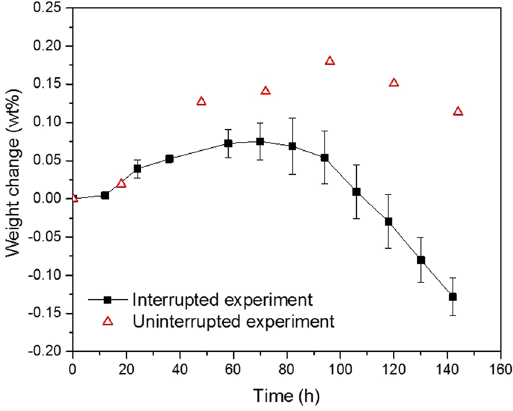
Figure 9. Weight change of the Zn plates during UV